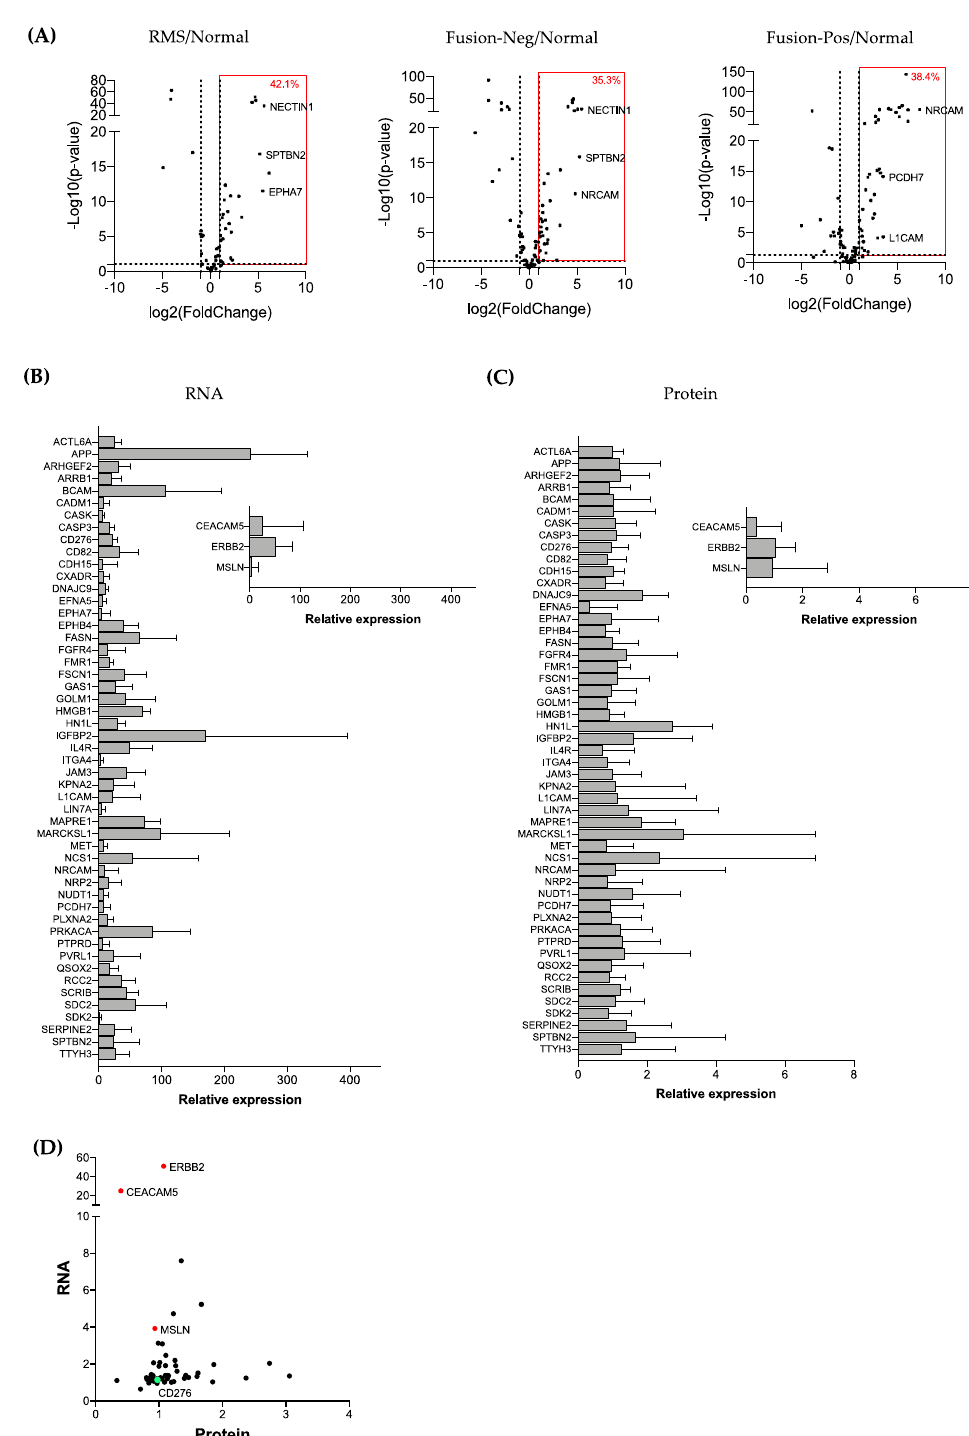
Figure 2. Validation of RMS-enriched cell-surface proteins by combined proteomic and transcriptomic analyses. ( A ) Volcano plot reporting p-values against fold changes for transcriptomic analysis of RMS tumors and normal muscle. The red box represents significantly up-regulated genes. Relative expression of ( B ) RNA and ( C ) protein of RMS-enriched cell-surface antigens in normal tissues including three CAR-T targets. ( D ) Correlation analysis between RNA and protein relative expression of RMS-enriched cell-surface antigens in normal tissues. Selected CAR-T targets and CD276 (B7-H3) are represented in red and green, respectively.